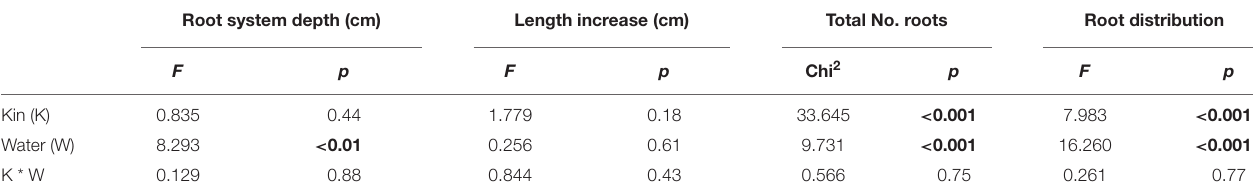
TABLE 3 | Statistical outputs testing the influence of kin, water treatment, and their 2-way interactions on Glechoma hederaceae root parameters measured in Experiment 2. Root system depth